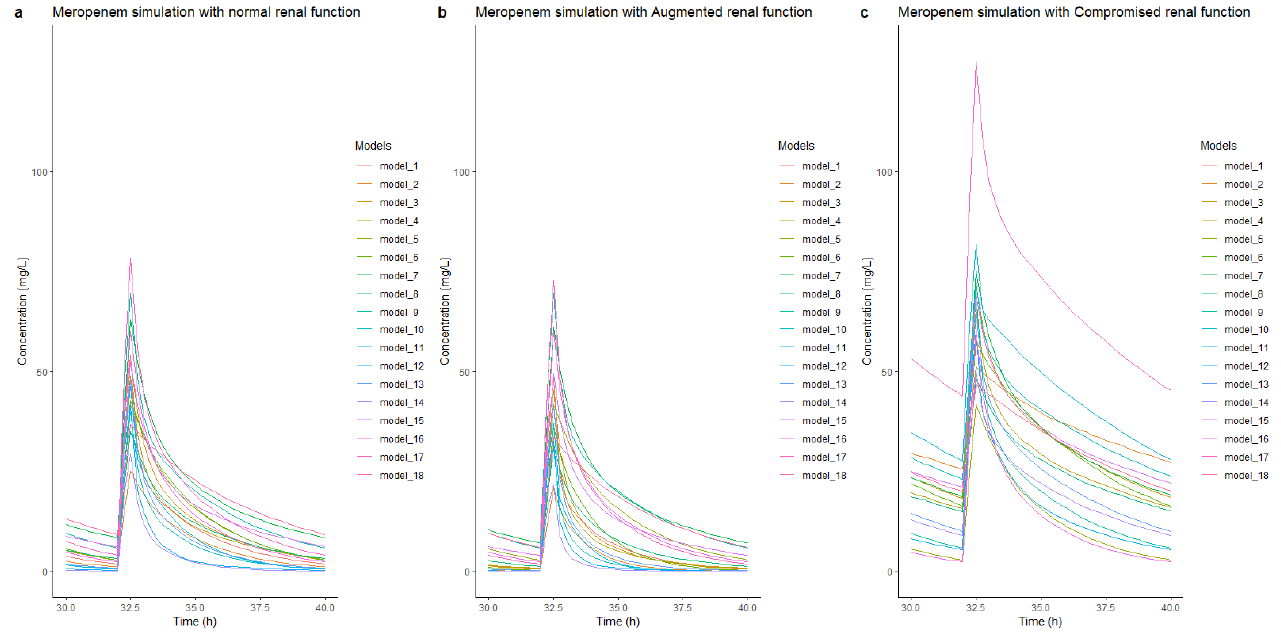
Figure 5. Steady-state concentrations and time simulation of the three typical patients with different renal functions: normal renal function ( a ), augmented renal function ( b ), and impaired renal function ( c ). The simulations were all based on a standard patient (55 years, 180 cm, 80 kg, APACHE II score 24, albumin 25 g/L, serum creatinine 100 umol/L). All received a meropenem dose of 1 g q8 h for 40 h. Steady-state concentrations were shown at the fourth dose (30–40 h after first dose).